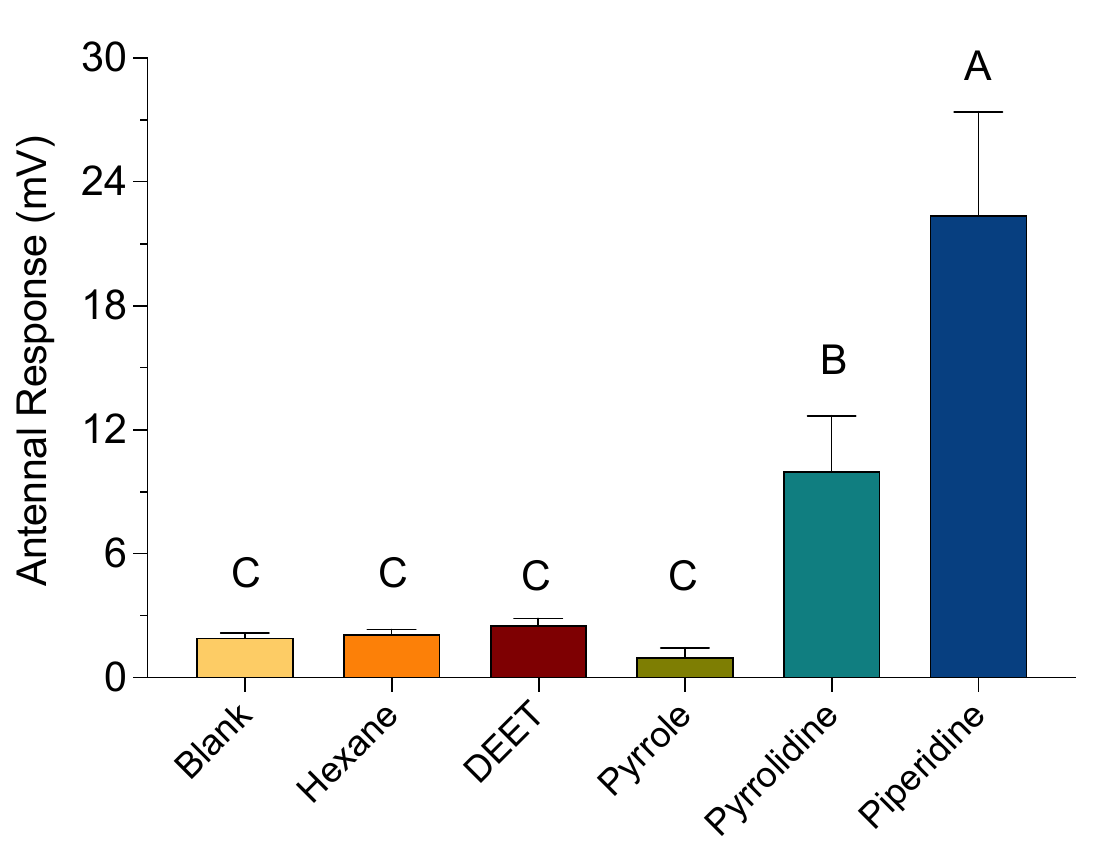
Figure 8. Electroantennogram (EAG) recordings of bee antennae exposed to heterocyclic amines (HCAs). The change in baseline voltage (mV) was calculated by subtracting the absolute value of the baseline voltage from the absolute value of the response voltage. An empty Pasteur pipette and hexane-treated filter paper served as a control (blank) and carrier solvent treatment, respectively. Bee antennae exposed to HCAs at 1000 µL/mL. Vertical bars represent the mean ± standard error. Different letters above the bars indicate a significant difference between treatments using an ANOVA with Tukey’s multiple comparison test ( P < 0.05).